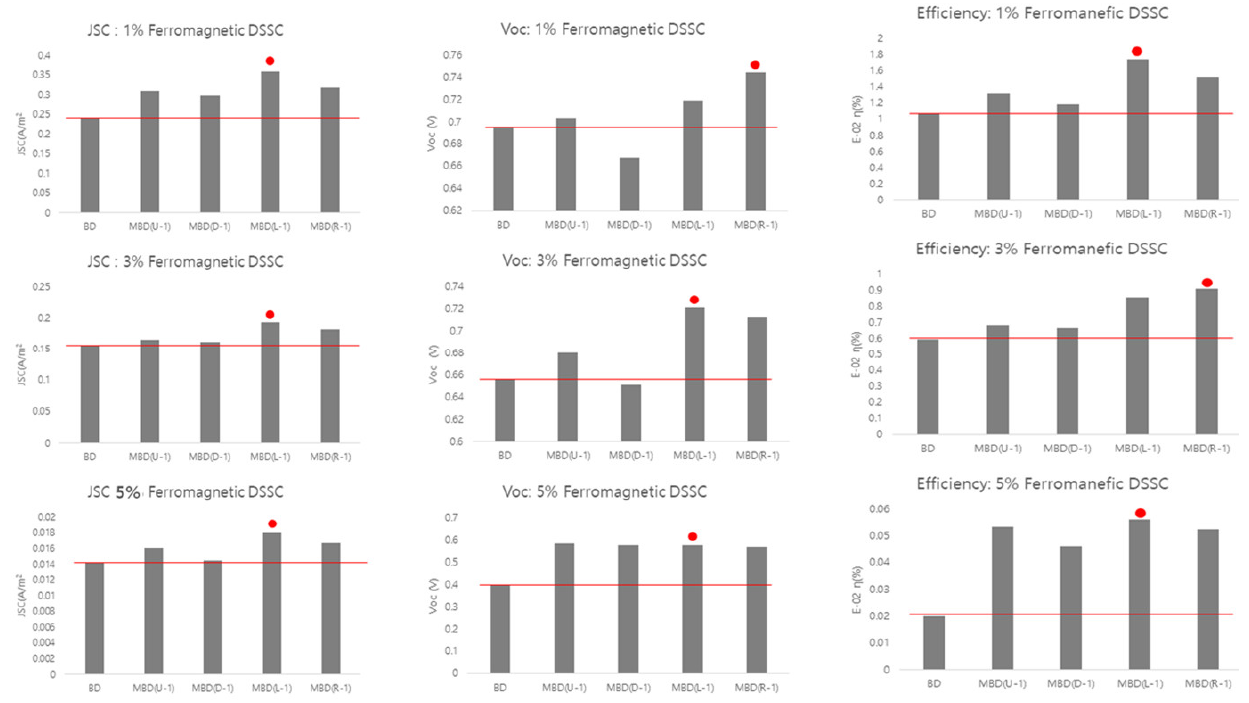
Figure 9. Ferromagnetic DSSC: J sc , V oc , and η Efficiency Comparison.